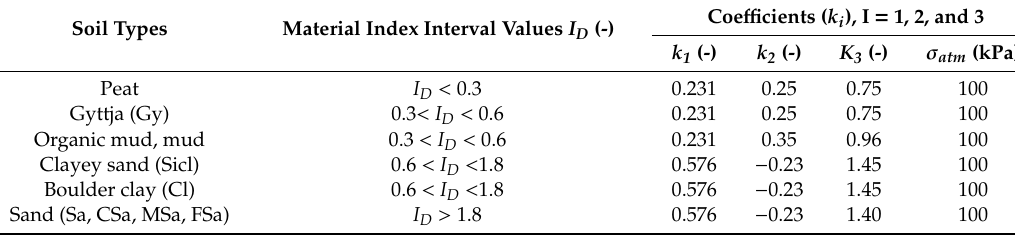
Table 3. Values of empirical coe ffi cients k 1 , k 2 , and k 3 for Equation